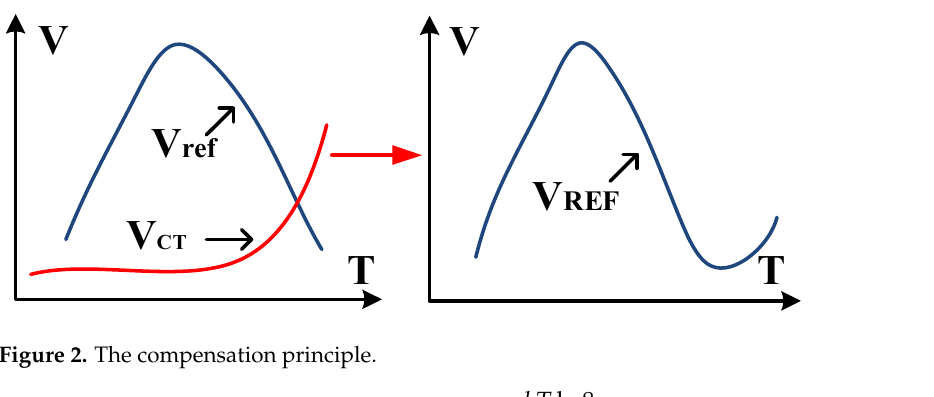
Figure 2. The compensation principle.